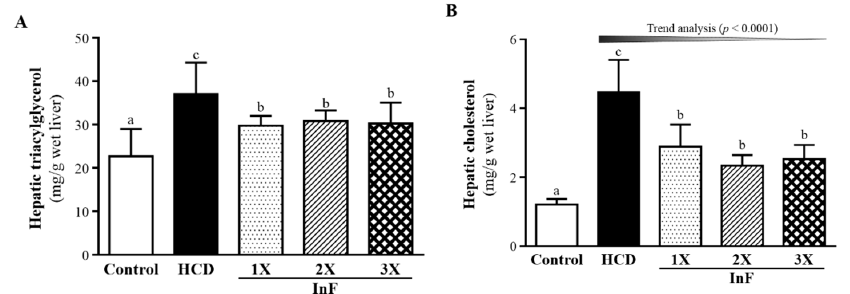
Figure 5. Effect of eight-week InF supplementation on hepatic TG ( A ) and TC ( B ) levels in hyperlipidemic hamsters. Data are mean ˘ SD ( n = 8/group); values with different letters (a, b, c) differ significantly at p < 0.05 by one-way